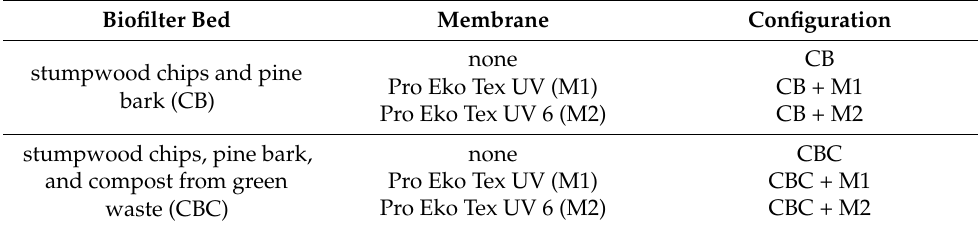
Table 2. Configurations of the biofilter tested during the experiment. Biofilter Bed Membrane Configuration stumpwood chips and pine bark (CB) stumpwood chips, pine bark, and compost from